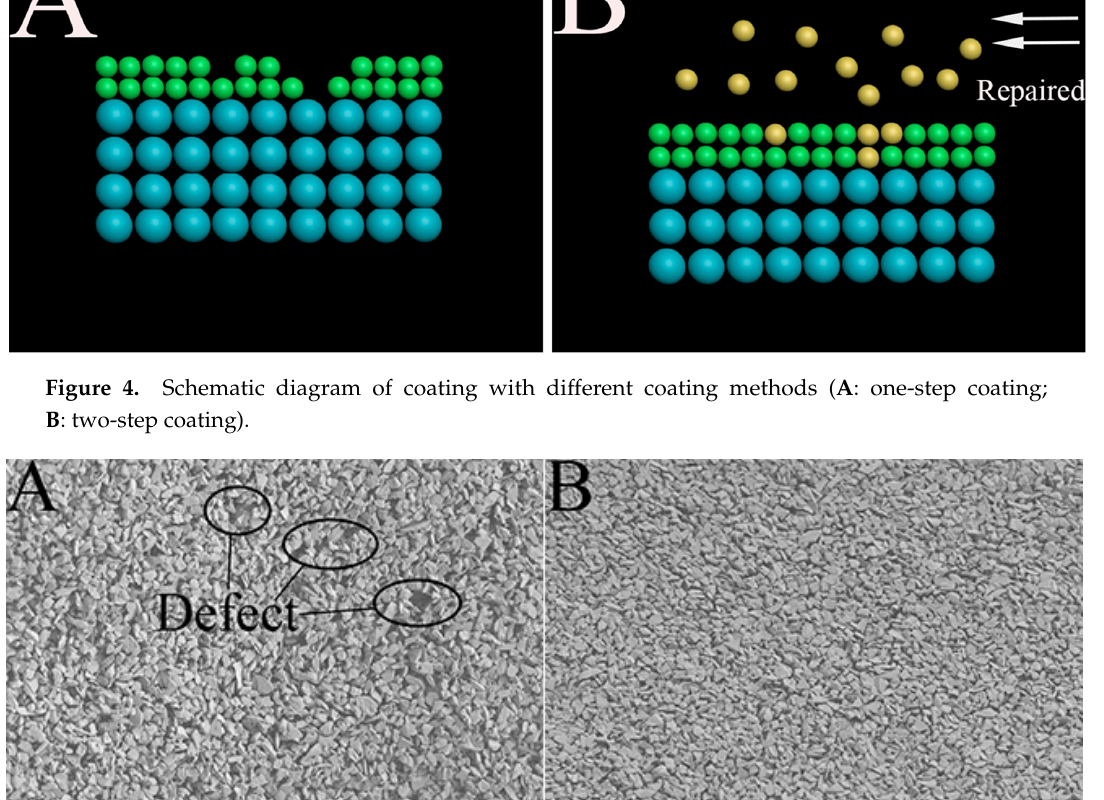
Figure 5. SEM images of the samples prepared by different coating methods. A —One-step coating method; B —Two-step coating method.